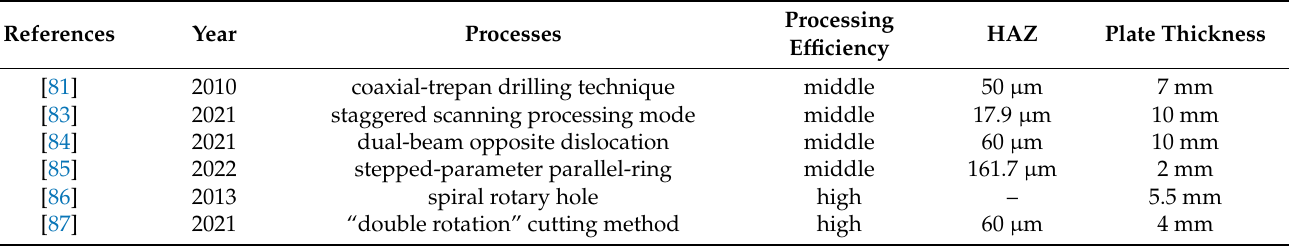
Table 3. Processing process